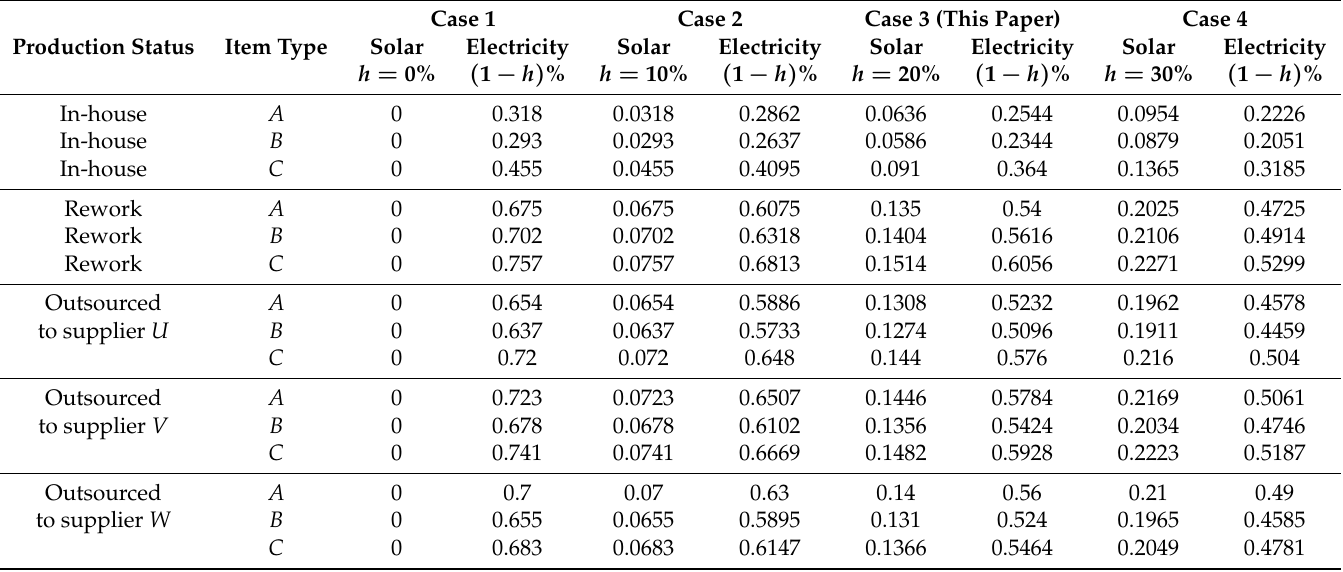
Table 11. Data showing different cases of energy utilizations in the automobile part